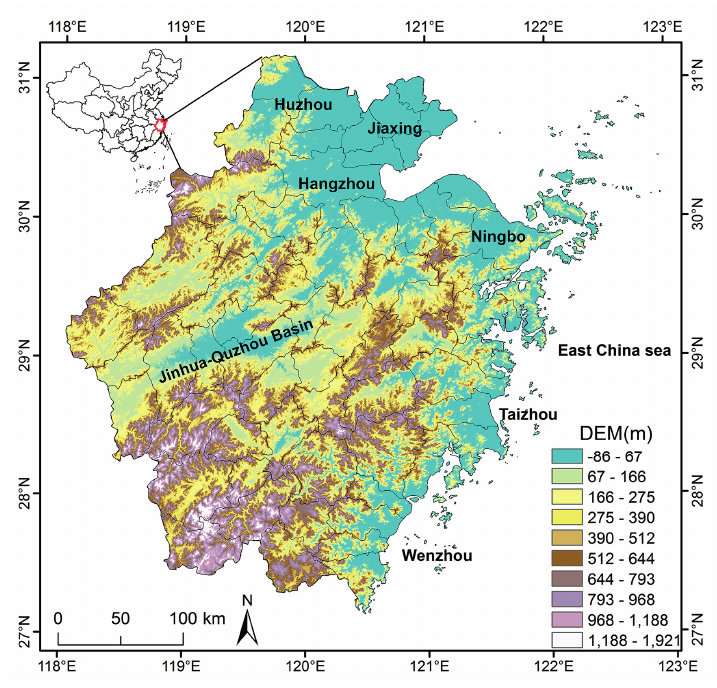
Figure 1. Location of study area and